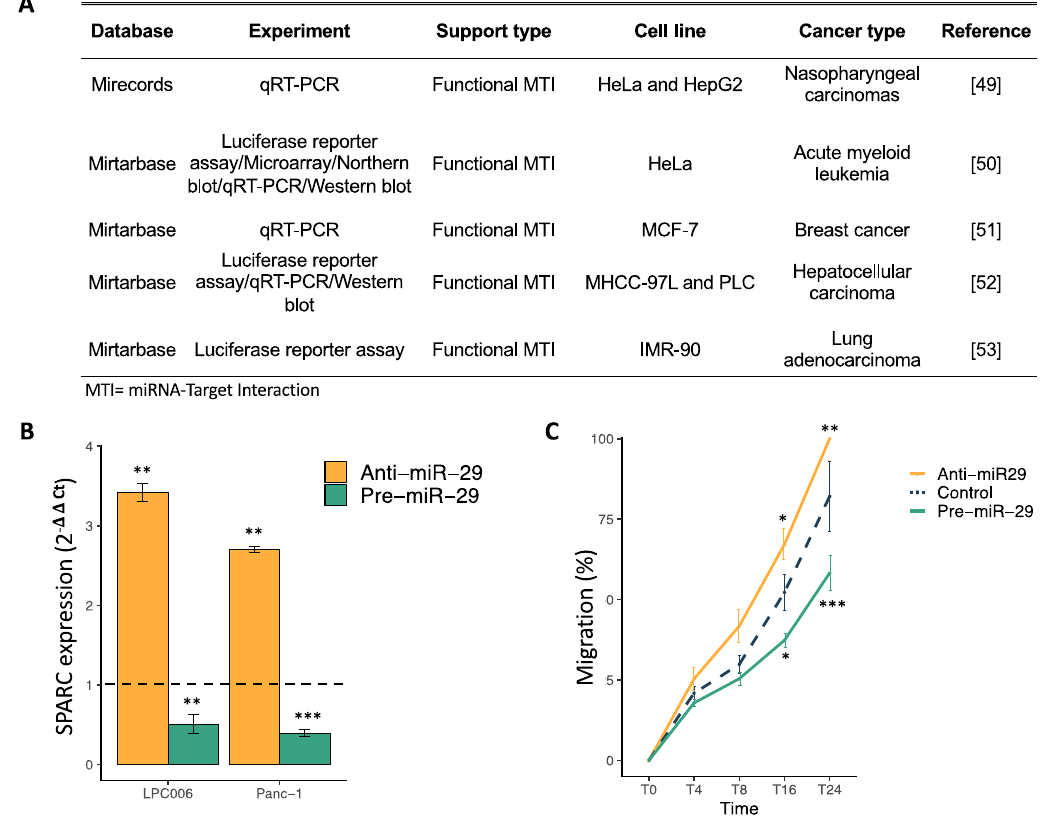
Figure 4. Validation of miR-29a-3p inhibitory effect on SPARC mRNA expression. ( A ) Table on previous studies validating the inhibition of SPARC caused by miR-29a-3p. ( B ) Modulation of SPARC mRNA expression levels after transfection with pre-miR-29a-3p (green) or anti-miR-29a-3p (orange) in LPC006 and Panc-1 cells. ( C ) Modulation of migration in LPC006 cells after transfection with anti-miR-29a-3p (orange), pre-miR-29a-3p (green) or miR-negative control (blue–dashed line). Significance was assessed with T-Student Test (* p < 0.05, ** p < 0.01, *** p < 0.0001). Dashed line refers to comparative levels in miR-negative controls.